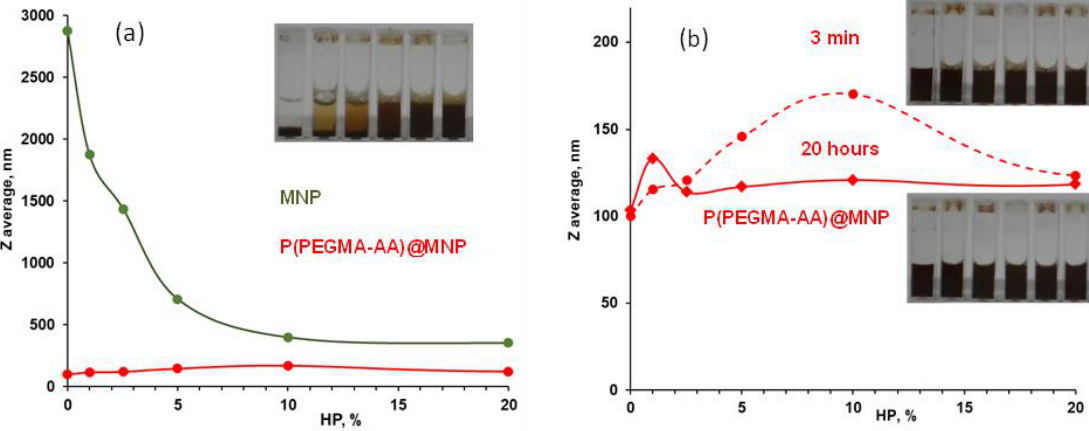
Figure 10. Changes in the hydrodynamic diameter of naked MNP (green) and P(PEGMA-AA)@MNP (red) as a function of the concentration of HP measured 3 min ( a ) and P(PEGMA-AA)@MNPs at 3 min and 20 h after dispersing in HP solution ( b ).